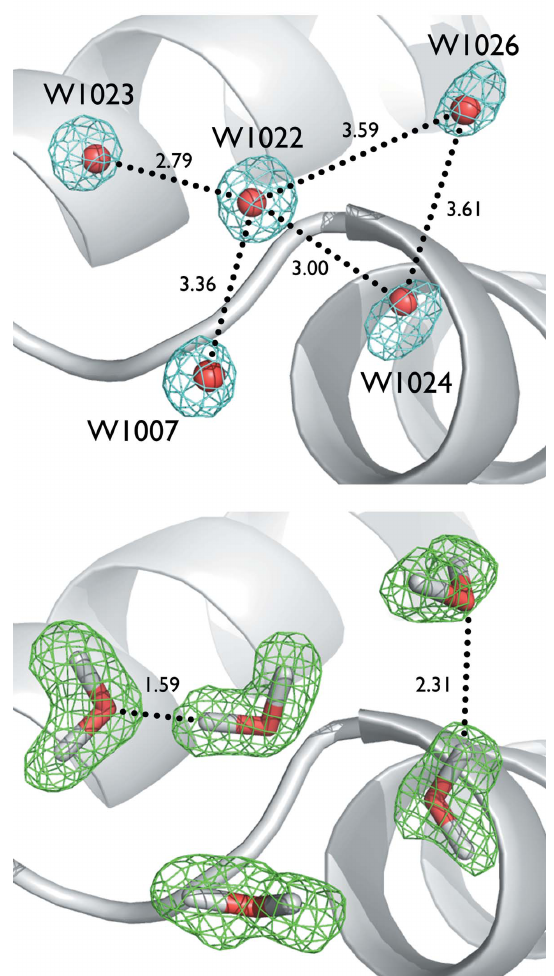
Figure 15 Anisotropic vibrational motions of selected D atoms in crambin. In green are the anisotropic ellipsoids of selected D atoms in crambin, with their respective hydrogen-bonding partners. N atoms are in blue, O atoms in red and C atoms in gray. Reprinted with permission from Chen et al. (2012), Proc. Natl Acad. Sci. USA , 109 , 15301–15306. Copyright (2012) National Academy of Sciences.